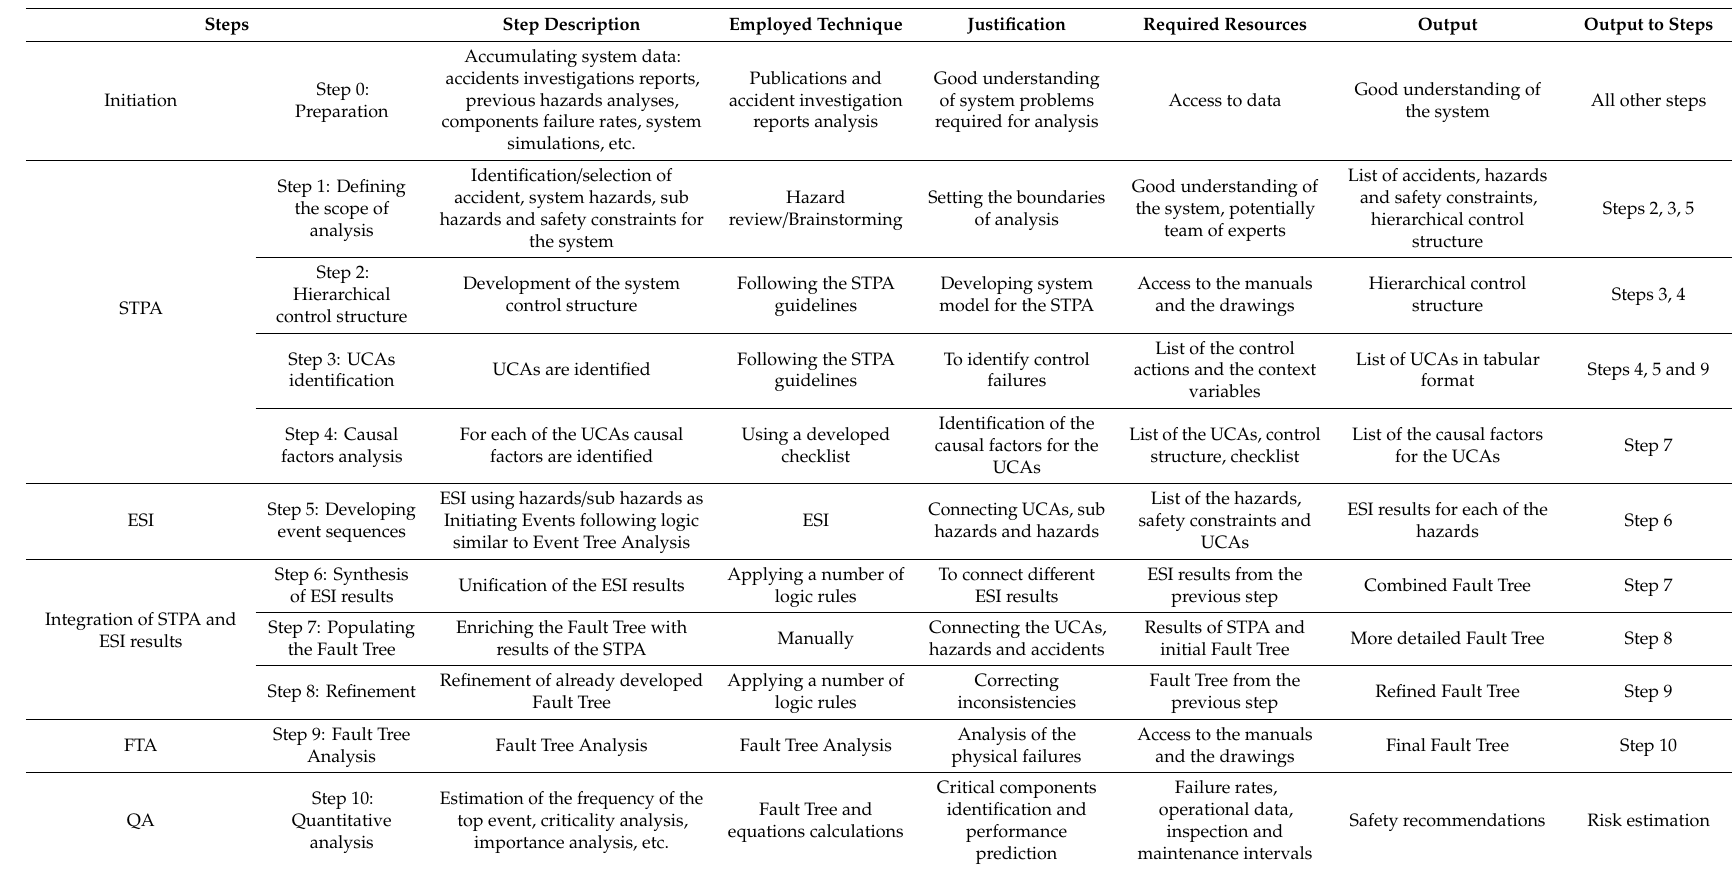
Table 1. CASA method steps